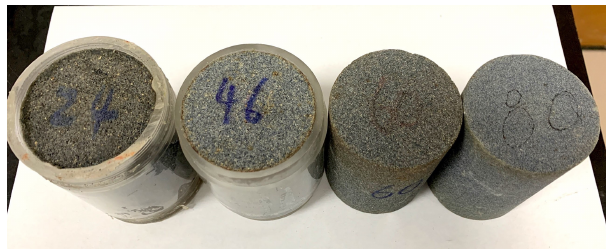
Figure 2. The photograph of permeable stones with four different particle sizes.